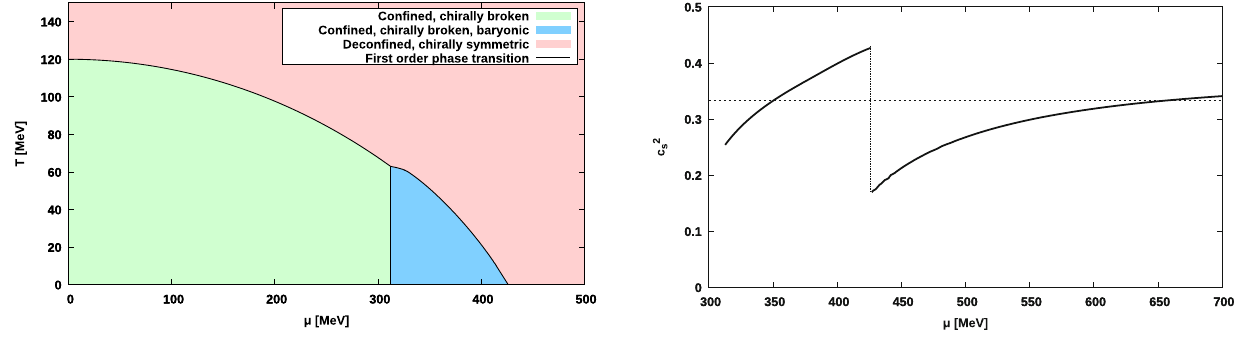
Fig. 14 The speed of sound at zero temperature as a function of the chemical potentials for potentials 7a, b = 10, and c b = 1. Figure taken from